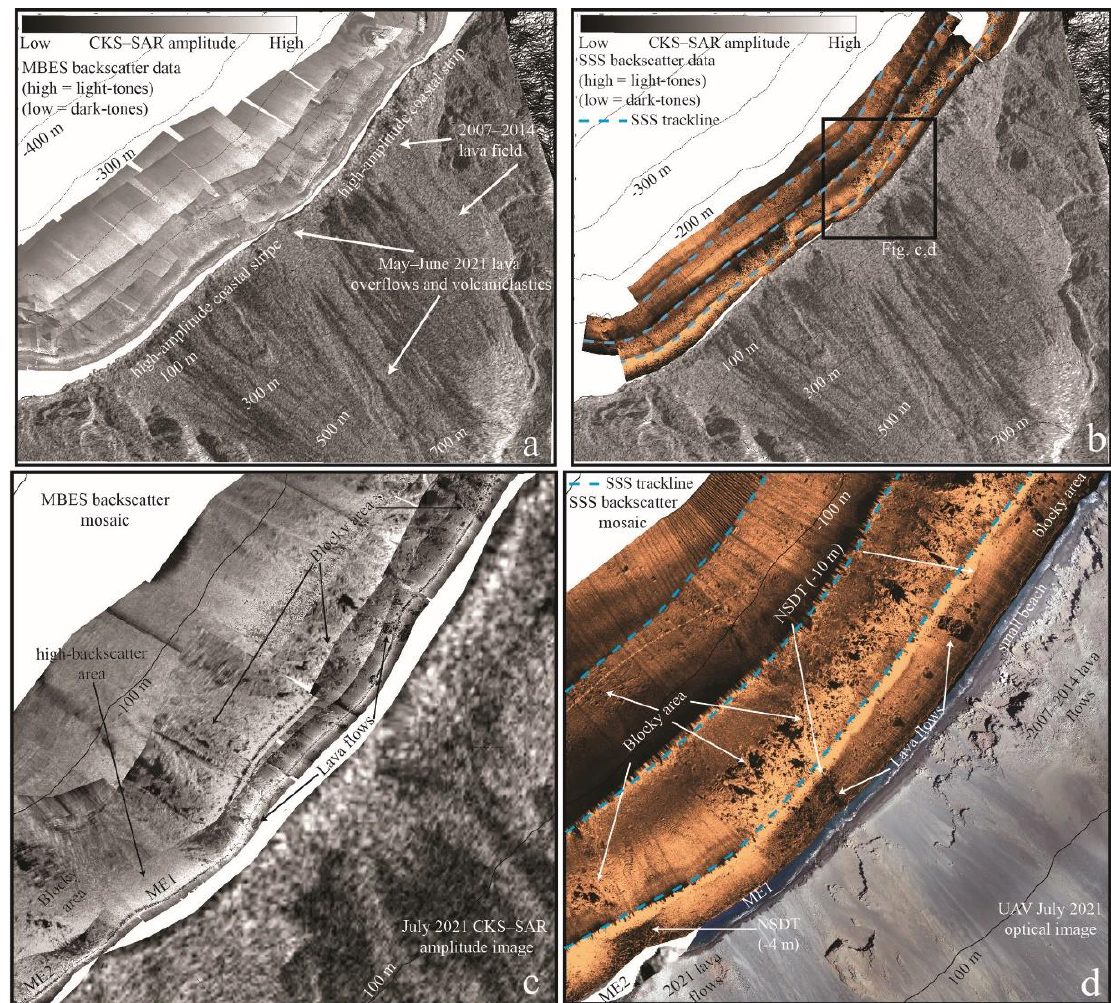
Figure 8. ( a ) 30 July 2021 CSK-SAR amplitude image of the subaerial SdF slope combined with the 27 July 2021 multibeam (MBES in ( a )) and side scan sonar (SSS in ( b )) backscatter data of the shallow submarine portion of the SdF; black lines are contours (equidistance 100 m), and blue dashed lines are the SSS track lines. ( c ) Zoom of MBES backscatter and CKS-SAR image; ( d ) Zoom of the SSS backscatter with the 7 July 2021 AUV optical image; ME1, ME2, and NSDT are as in in the previous figures. Note that SSS data ensonified seafloor areas more proximal to the coast with respect to MBES data due to the different acquisition geometry of the two systems.